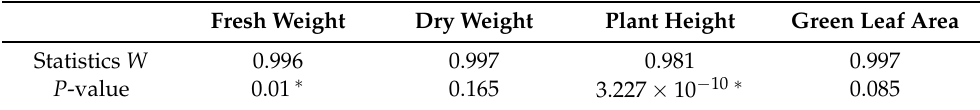
Table 5. Linear Mixed Effect model residual normality test.